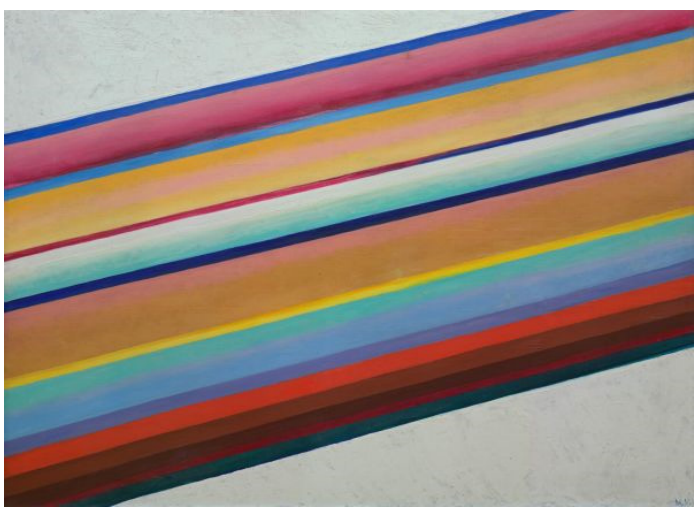
Figure 1. Mikhail Matyushin. Movement in Space , 1921, oil on canvas, 124 × 168 cm, Russian Museum, St. Petersburg.